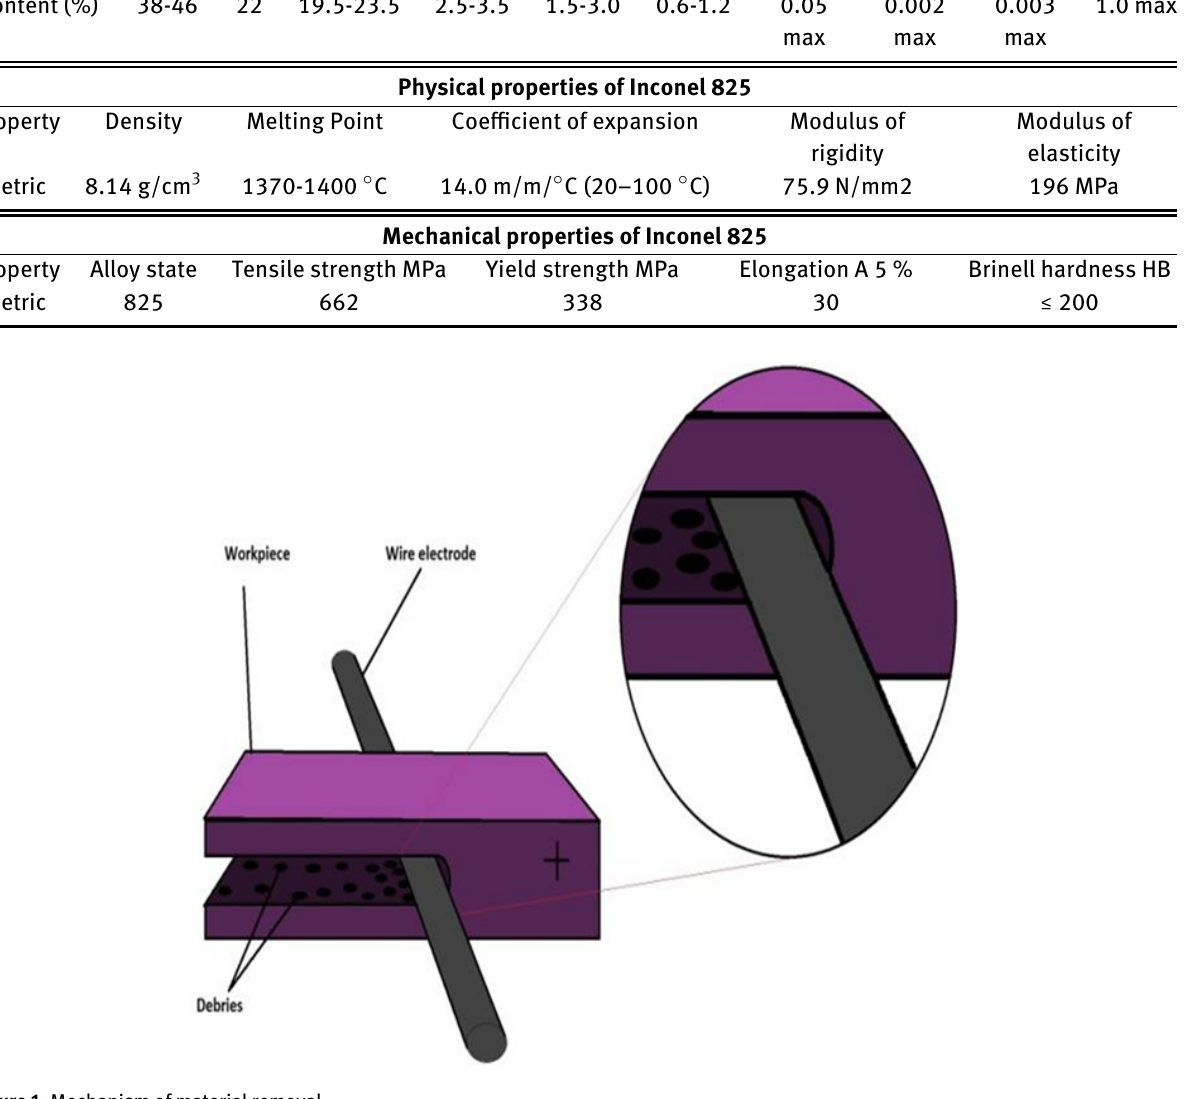
Figure 1: Mechanism of material